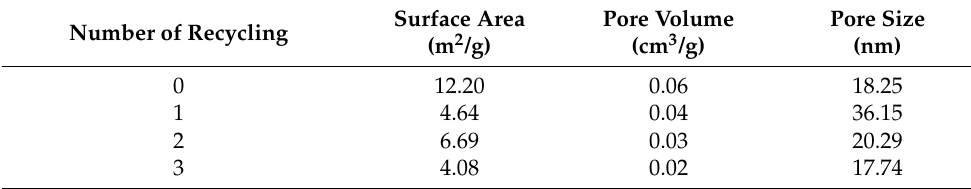
Table 6. The surface area and pore volume of nondegradable solids (NDS). Number of